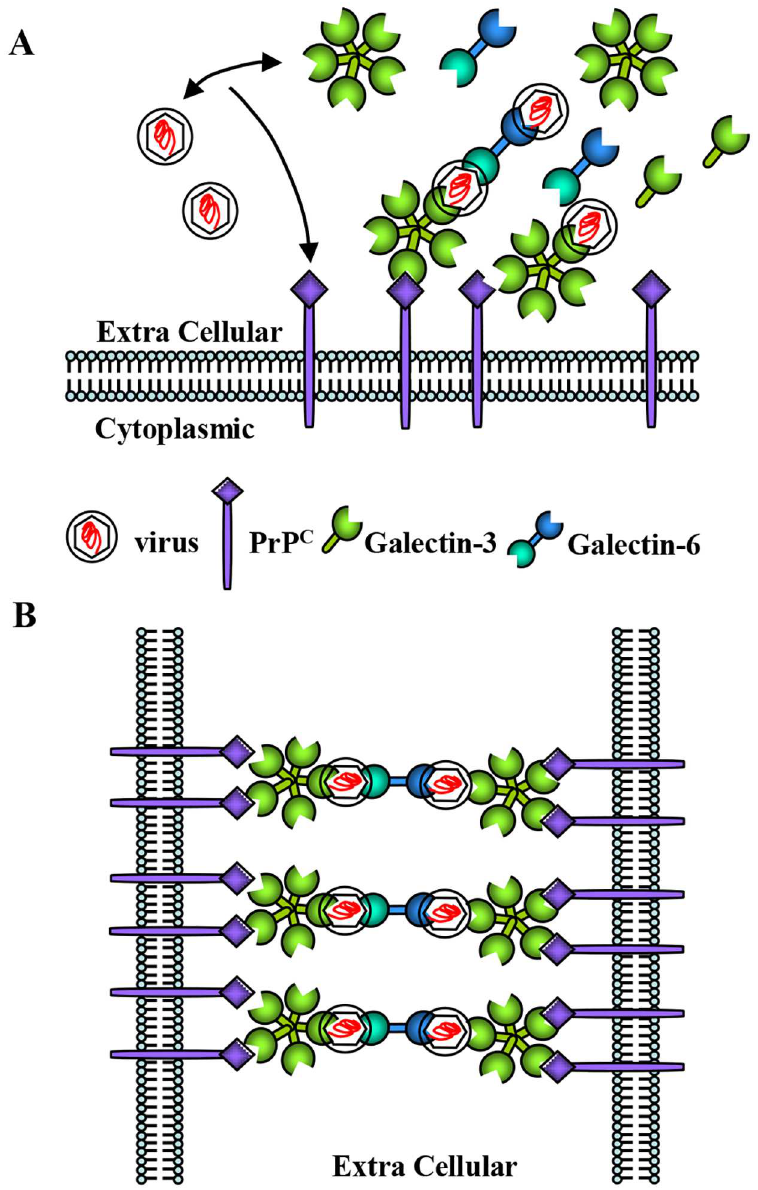
Fig 7. The cell-cell adhesion mechanisms to form plaques. (A) Scheme of PrP-MuLV-Gal interactionin cell membrane. (B) Based on our data betweenthe cells PrP-Gal3 has bindingactivity and Gal3-CAgag-Gal6 shows bindingactivity. To producethe plaques,Gal3 is suggestedto combinebetweenPrP and MuLV. Gal6 is suggested to combinetwo different viruses to form